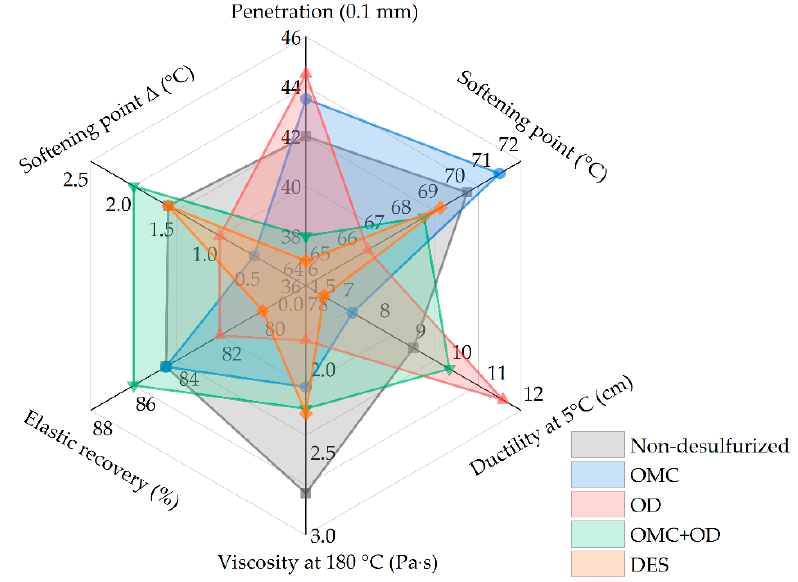
Figure 2. Radar chart for of desulfurizer type comparison based on physical properties of crumb rubber modified asphalt.